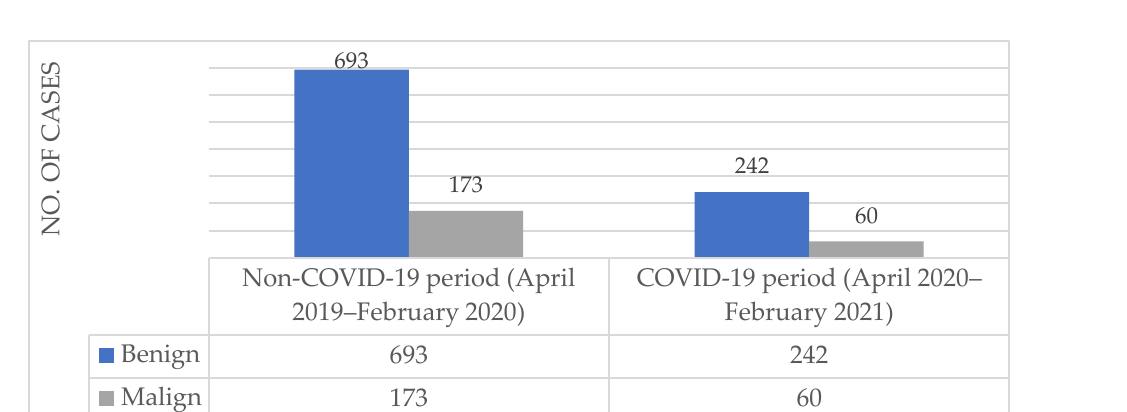
Figure 2. The counts of benign and malignant histopathological diagnoses established between April 2019 and February 2020 and between April 2020 and February 2021 in the dermatopathology ward of Mures Clinical County Hospital, Targu Mures, Romania.